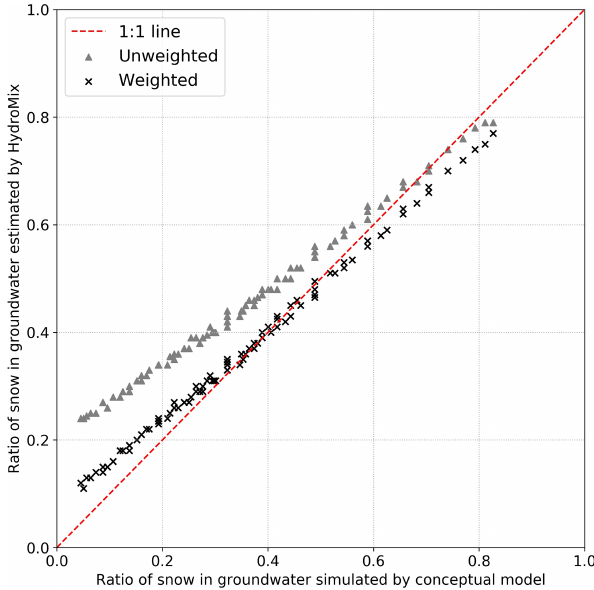
Figure 7. Ratios of snow in groundwater estimated using HydroMix plotted against ratios obtained from the hydrologic model for both weighted and unweighted mixing scenarios. The full range of ratios is obtained by varying rainfall and snowmelt recharge efficiencies from 0.05 to 0.95. The numbers of rainfall, snowfall, and snowmelt days are 39, 24, and 107 in the last 2 years of